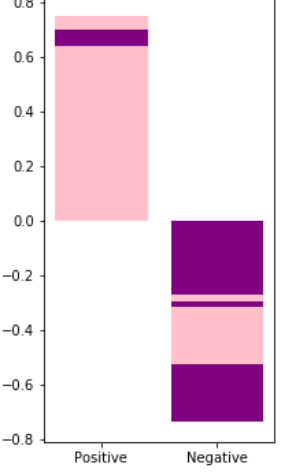
Figure 7. IndusInd news sentiments.